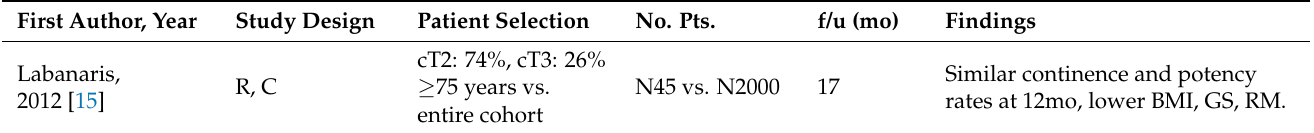
Table 1. Previous studies evaluating perioperative outcomes of radical prostatectomy in men aged ≥ 75